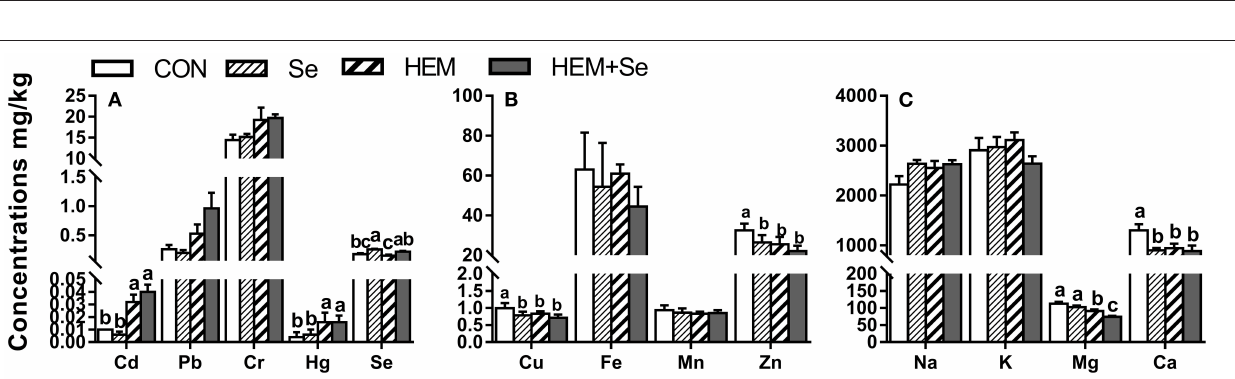
FIGURE 4 | The effect of selenium and cadmium, lead, mercury, chromium Co-treatment on the concentrations of ions in the oviduct (Wet Basis mg/kg) of laying hens from 63 to 74 wk of age. CON, corn-soybean meal basal dietary; Se, the basal dietary supplemented with 0.4 mg/kg selenium from selenized yeast (the selenium concentration was 0.14 mg/kg in the CON diet); HEM, the basal dietary supplemented with 5 mg/kg cadmium from CdCl 2 , 50 mg/kg lead from Pb(NO 3 ) 2 , 3 mg/kg mercury from HgCl 2 and 5 mg/kg chromium from CrCl 3 ; HEM + Se, the HEM dietary supplemented with 0.4 mg/kg selenium from selenized yeast. (A) The effect of selenium and cadmium, lead, mercury, chromium Co-treatment on the concentrations of cadmium, lead, chromium, mercury, selenium in the oviduct. (B) The effect of selenium and cadmium, lead, mercury, chromium Co-treatment on the concentrations of copper, iron, manganese, zinc in the oviduct. (C) The effect of selenium and cadmium, lead, mercury, chromium Co-treatment on the concentrations of sodium, potassium, magnesium, calcium in the oviduct. a, b, c Bars without a shared common letter are significantly different ( p < 0.05). Data show the mean ± SEM ( n = 10).